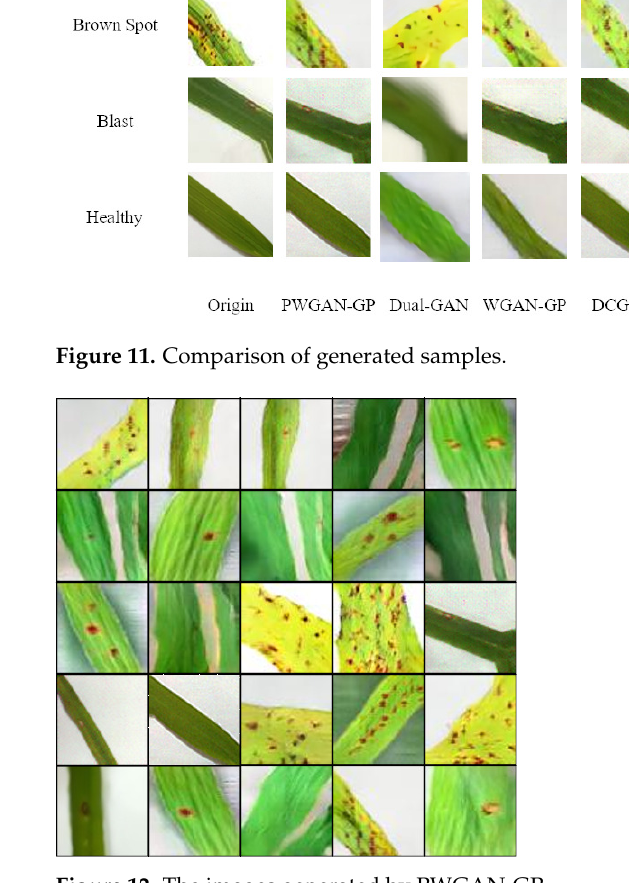
Figure 12. The images generated by PWGAN-GP.